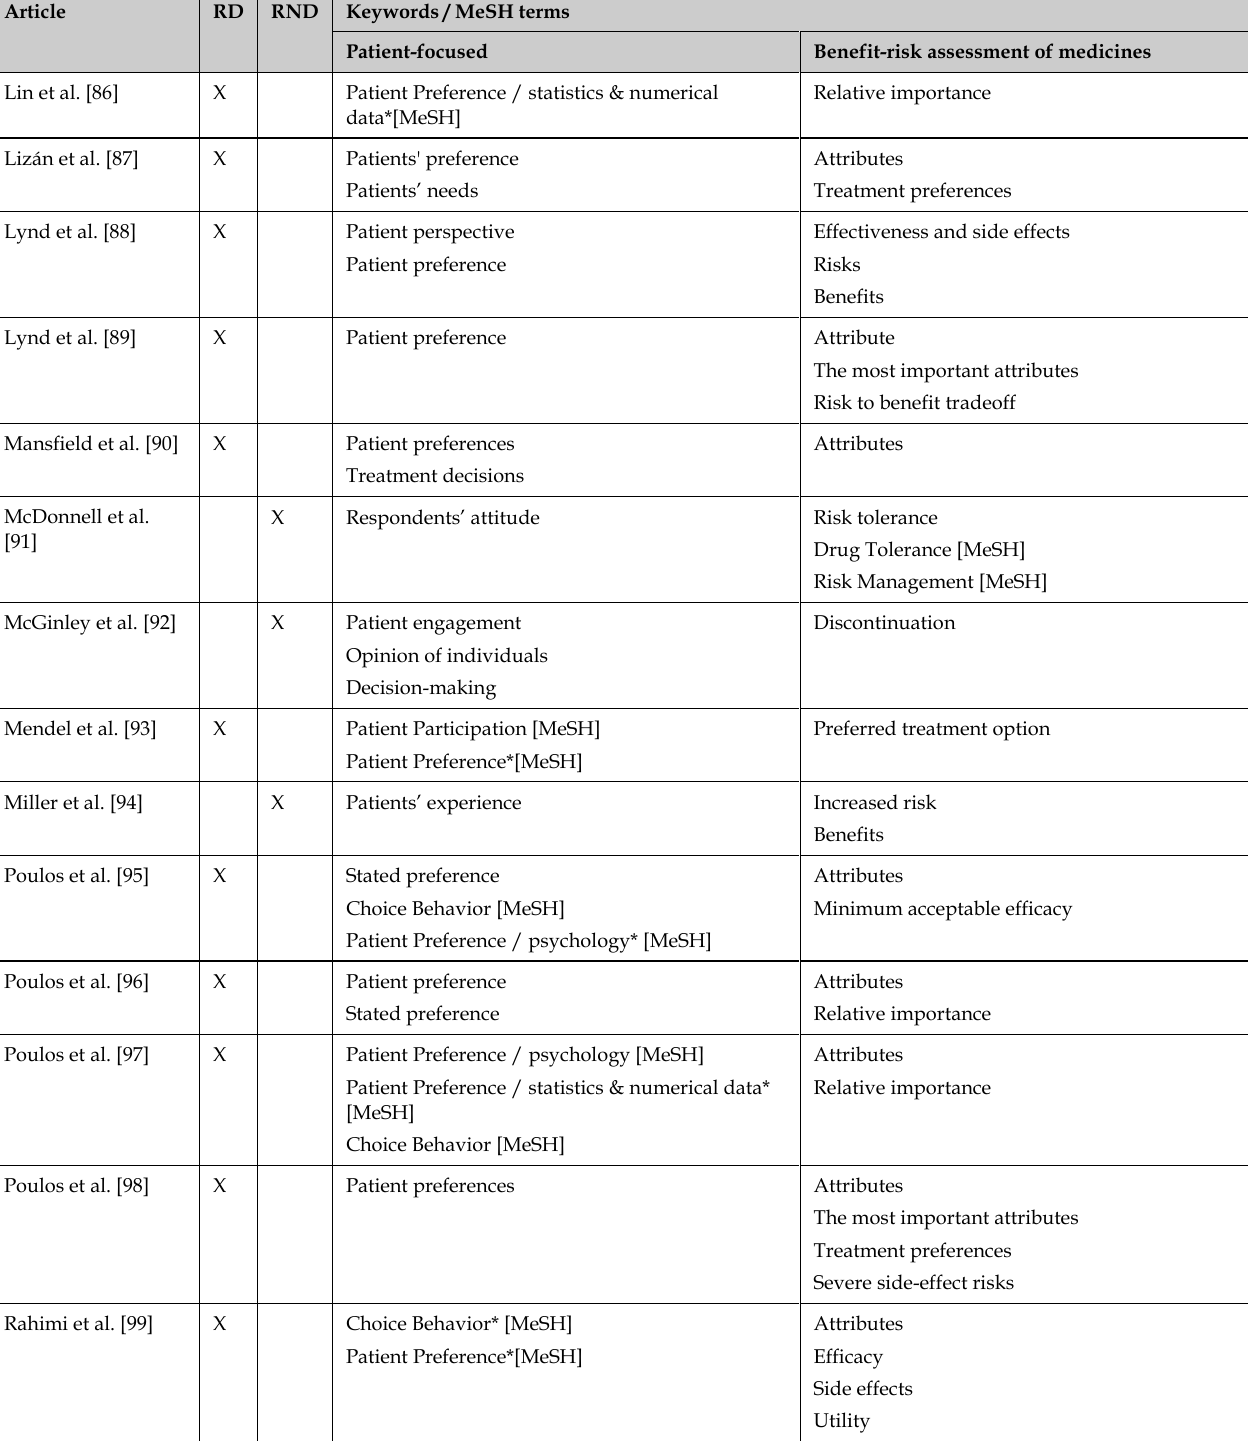
Table 3 Relevant articles on multiple sclerosis patients’ preferences regarding their medicines detected (RD) and not detected (RND) by the search strategy with corresponding keywords and MeSH terms